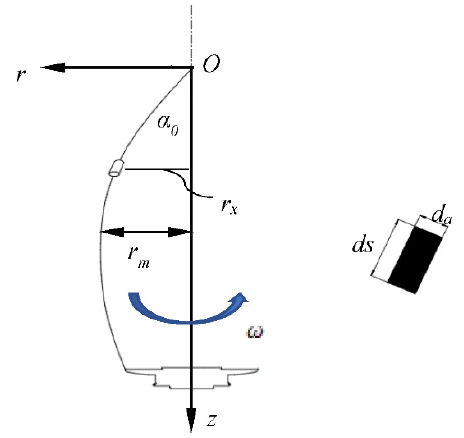
Figure 1. Micro-element modeling diagram of the balloon.